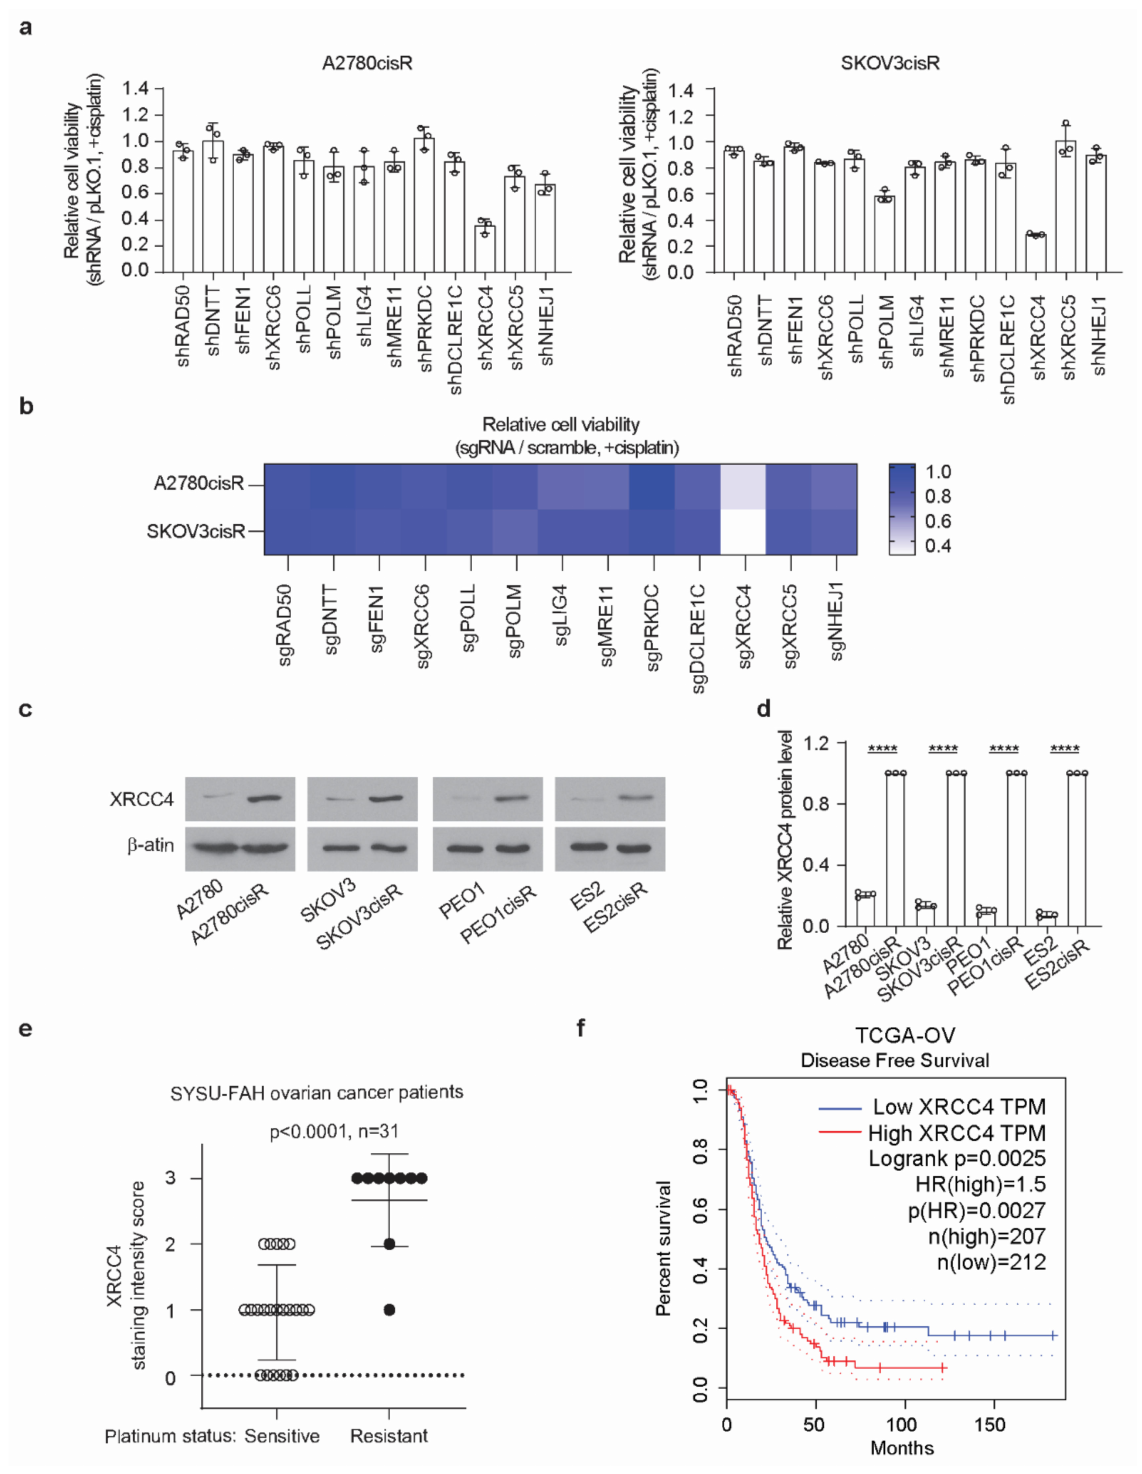
Figure 1. XRCC4 upregulation is associated with cisplatin resistance in ovarian cancer cells. ( a ) Results of synthetic lethality screen targeting 13 genes in NHEJ pathway using shRNAs with cisplatin in cisplatin-resistant ovarian cancer cell lines. A2780cisR and SKOV3cisR cells were infected with pooled shRNA lentivirus and sublethal doses of cisplatin (5 µ g/mL A2780cisR and 2 µ g/mL SKOV3cisR) for 48 h. Cell viability was determined by CellTiter-Glo luminescent cell viability assay. ( b ) Secondary screen used sgRNA to confirm the primary screen results. Cas9-expressing